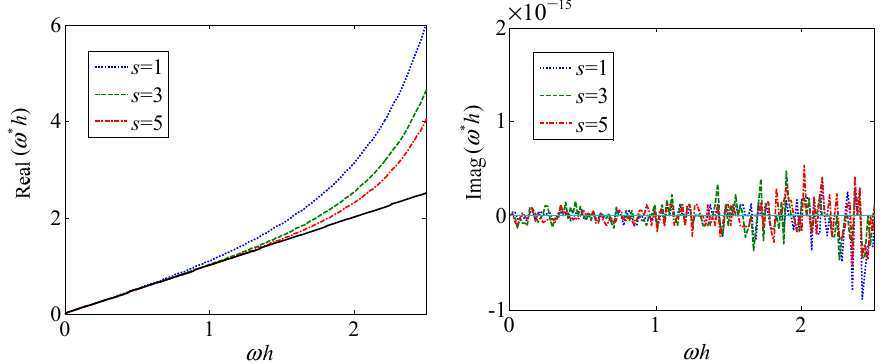
Figure 7. Plot of real and imaginary parts of the modified wavenumber for ETR 2 .